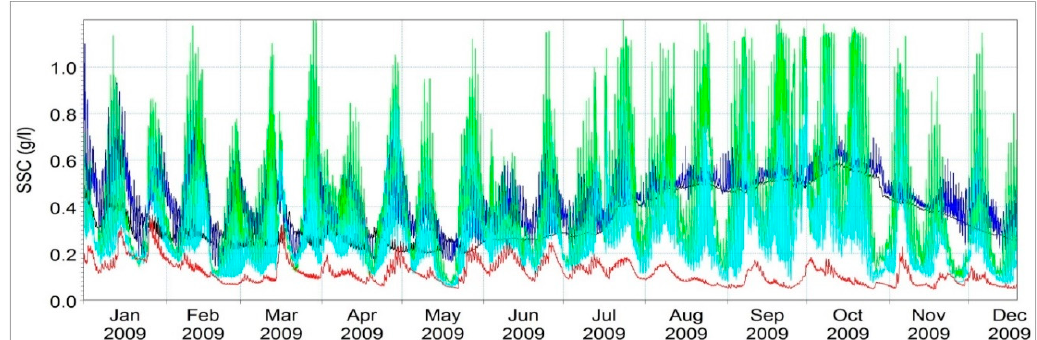
Figure 12. Time series of the distribution of SSC (g L − 1 ) at stations S0, D2, S11, S12, and T1. Surface layer ( top panels ); middle layer ( middle panels ); bottom layer ( bottom panels ).